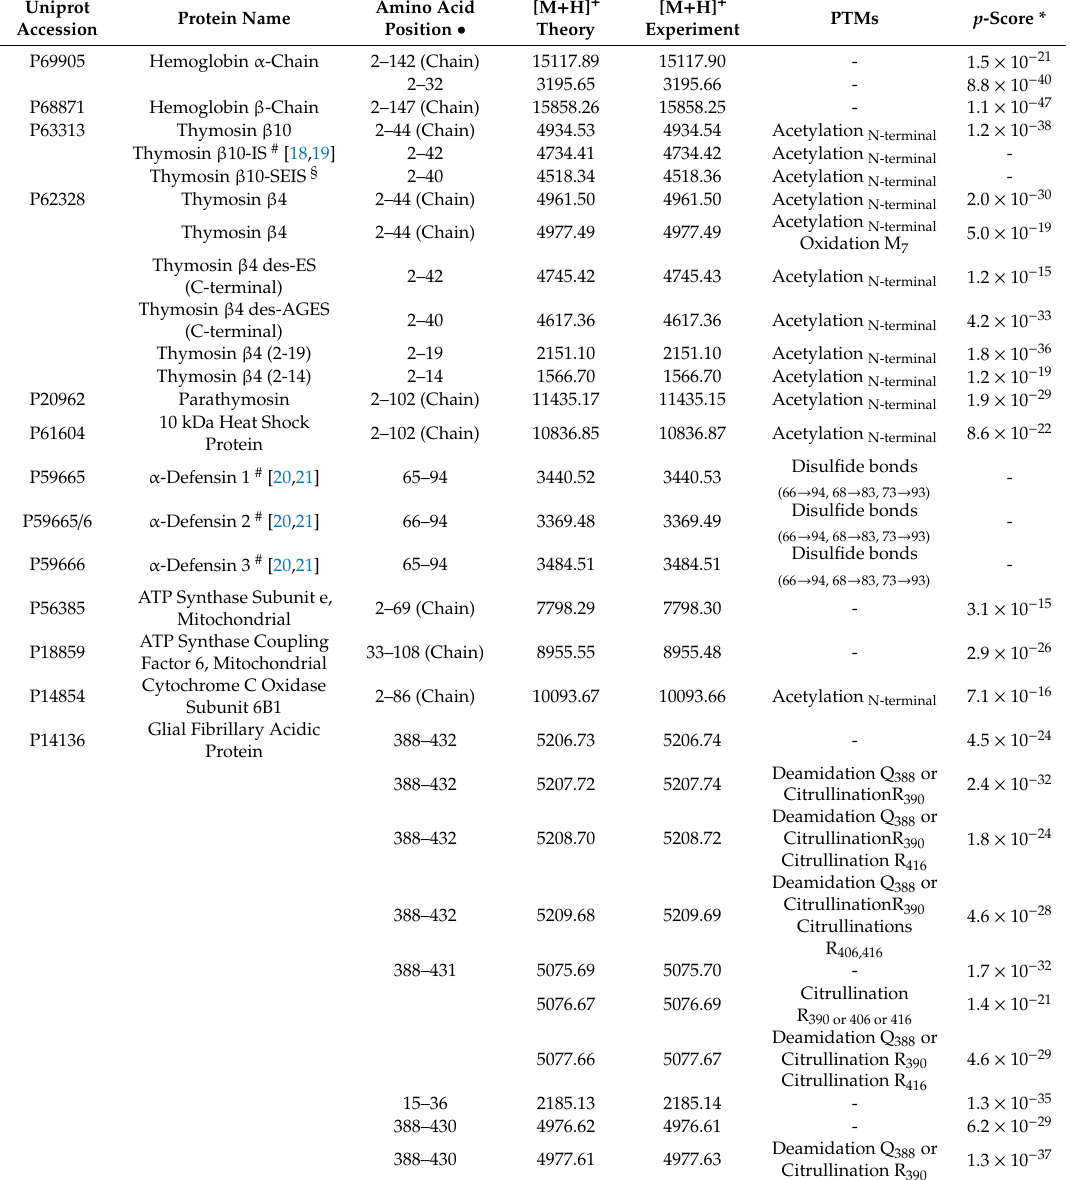
Table 1. Proteins and peptides identified in ependymoma (EP) tumor tissues following the top-down